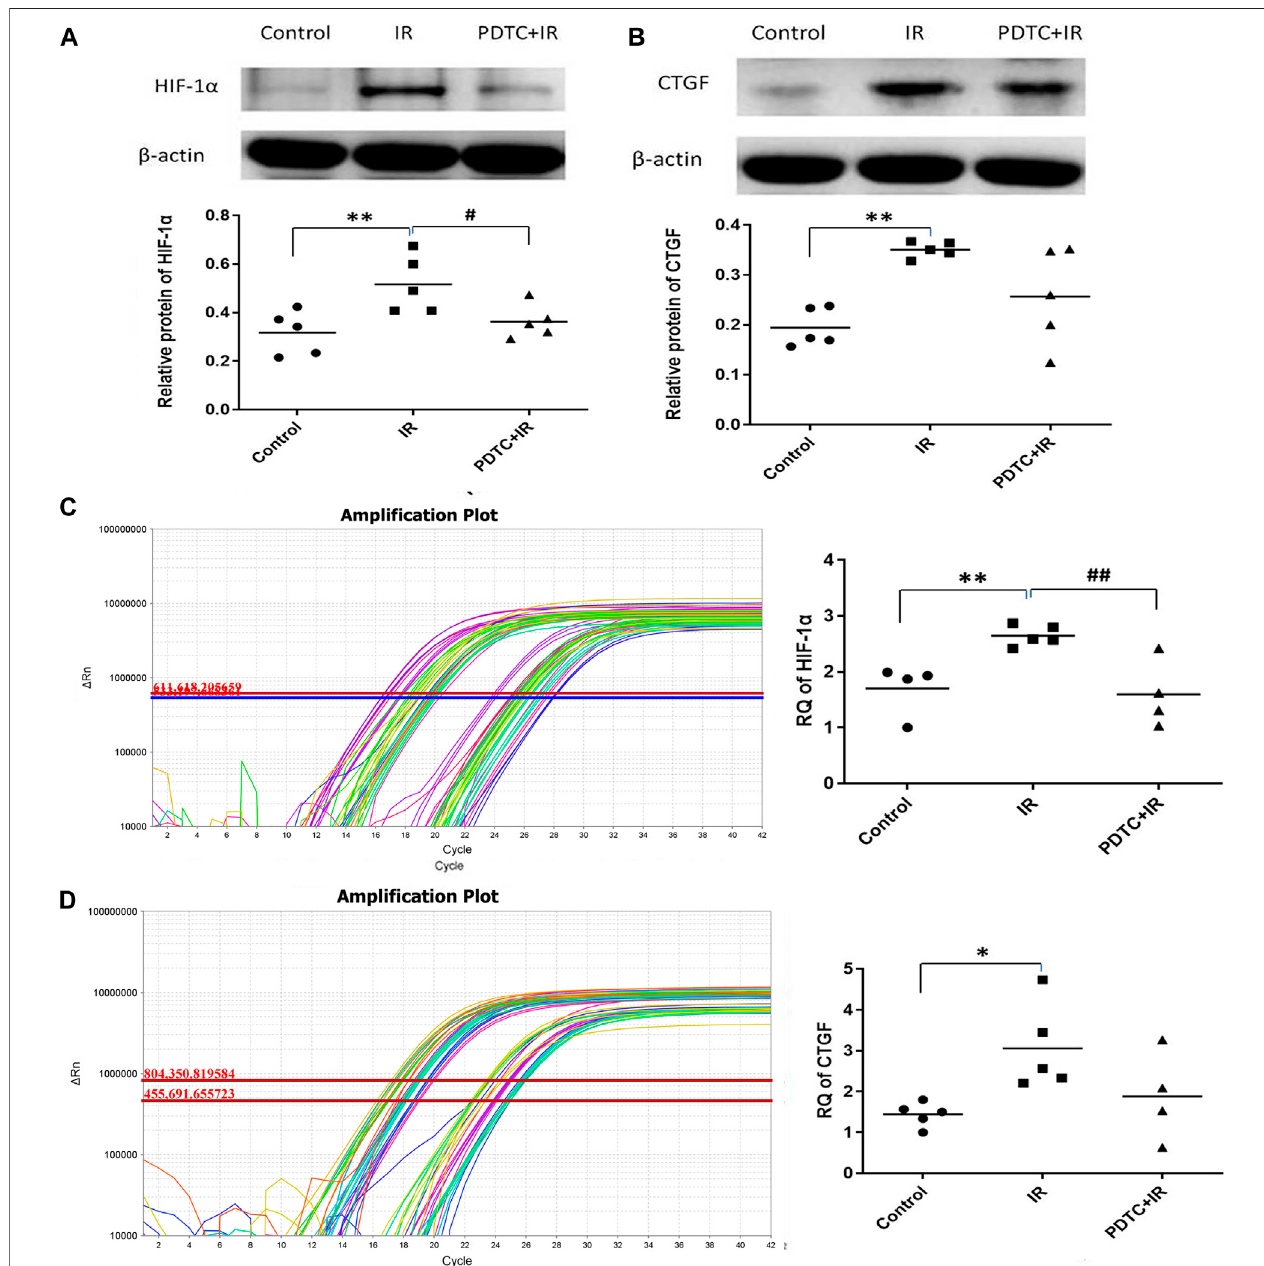
FIGURE6| EffectsofPDTContheexpressionofHIF-1 α andCTGFproteinsandmRNAsinmyocardialtissue. (A) and (B) showtheHIF-1 α andCTGFproteinlevels revealed by Western blot (C) and (D) show the mRNA levels of HIF-1 α and CTGF analyzed by qPCR. n = 5. * p < 0.05 for irradiation vs. control group; ** p < 0.01 for irradiation vs. control group; # p < 0.05 for PDTC + irradiation vs. irradiation group; ## p < 0.05 for PDTC + irradiation vs. irradiation group.